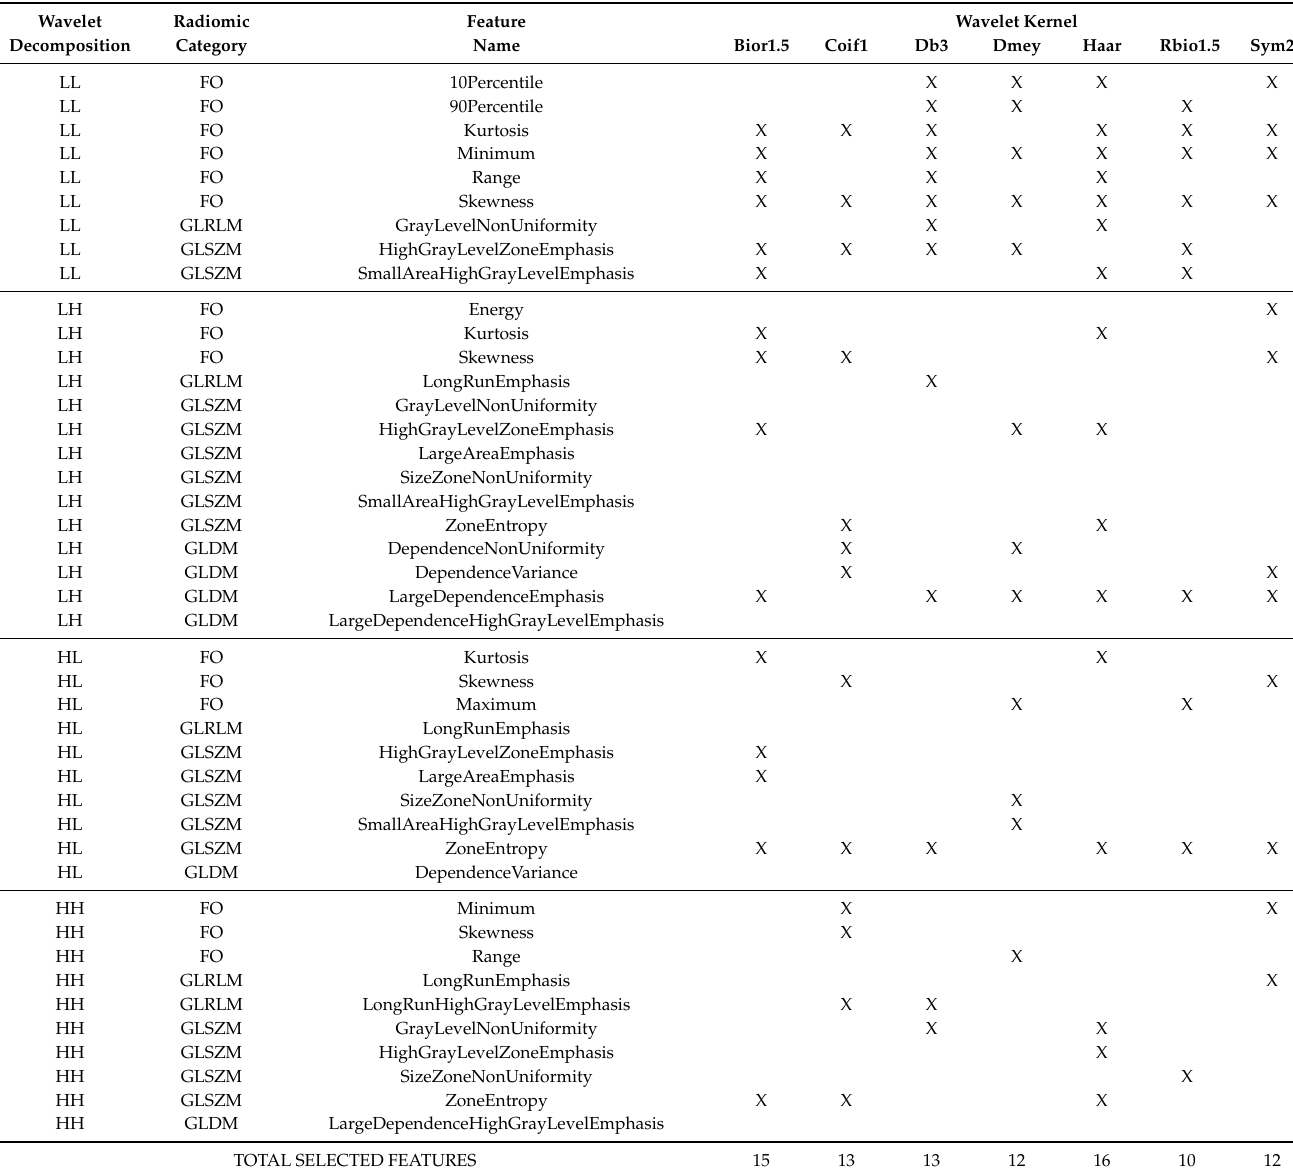
Table A3. Complete list of radiomic features selected via SFS, considering RF model for each wavelet kernel